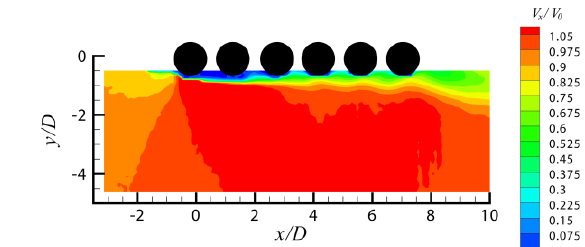
Fig. 3. Normalized mean streamwise velocity component contour plot obtained for lateral region